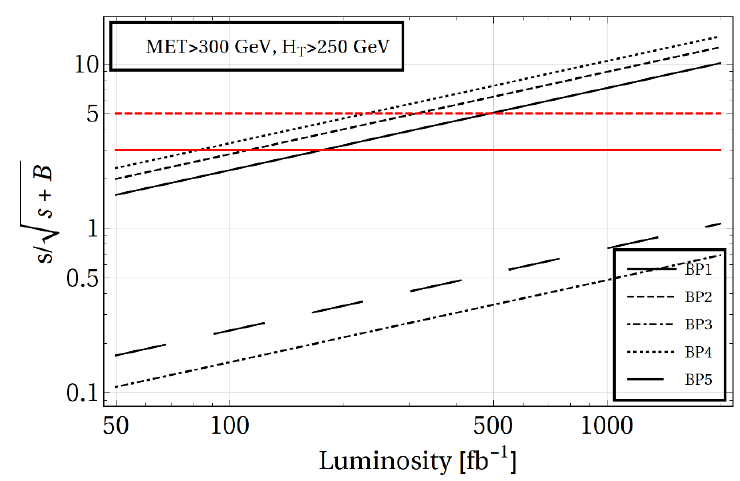
Figure 14 . Signi(cid:12)cance of benchmark points BP(1-5) at the LHC in terms of integrated luminosity. The solid red and dashed red lines correspond to 3 (cid:27) and 5 (cid:27) discovery limits respectively.